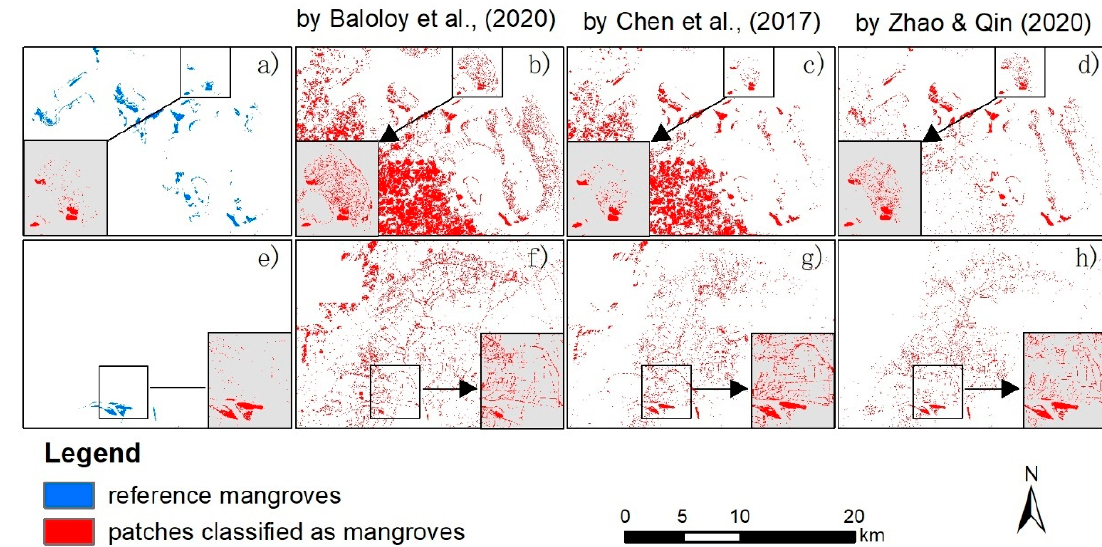
Figure 11. Spatial distribution of classification results for selected subset areas by different classification methods. These approaches, including a threshold approach based on the mangrove vegetation index (MVI) by Baloloy, et al. [31] in ( b ) and ( f ), a phenology-based approach by Chen, et al. [14] in ( c ) and ( g ), and a random forest (RF)-based classification approach by Zhao and Qin [18] in ( d ) and ( h ), have varied data sources, features, and classification schemes. Reference maps for subset areas are shown in ( a ) and ( e ). Zoom-in figures are used to compare classification details. The classification results with a classification scheme considering non-mangrove near water using the same total features (i.e., classification results with the new scheme in the first experiment) are shown in zoom-in figures in ( a ) and ( e ).